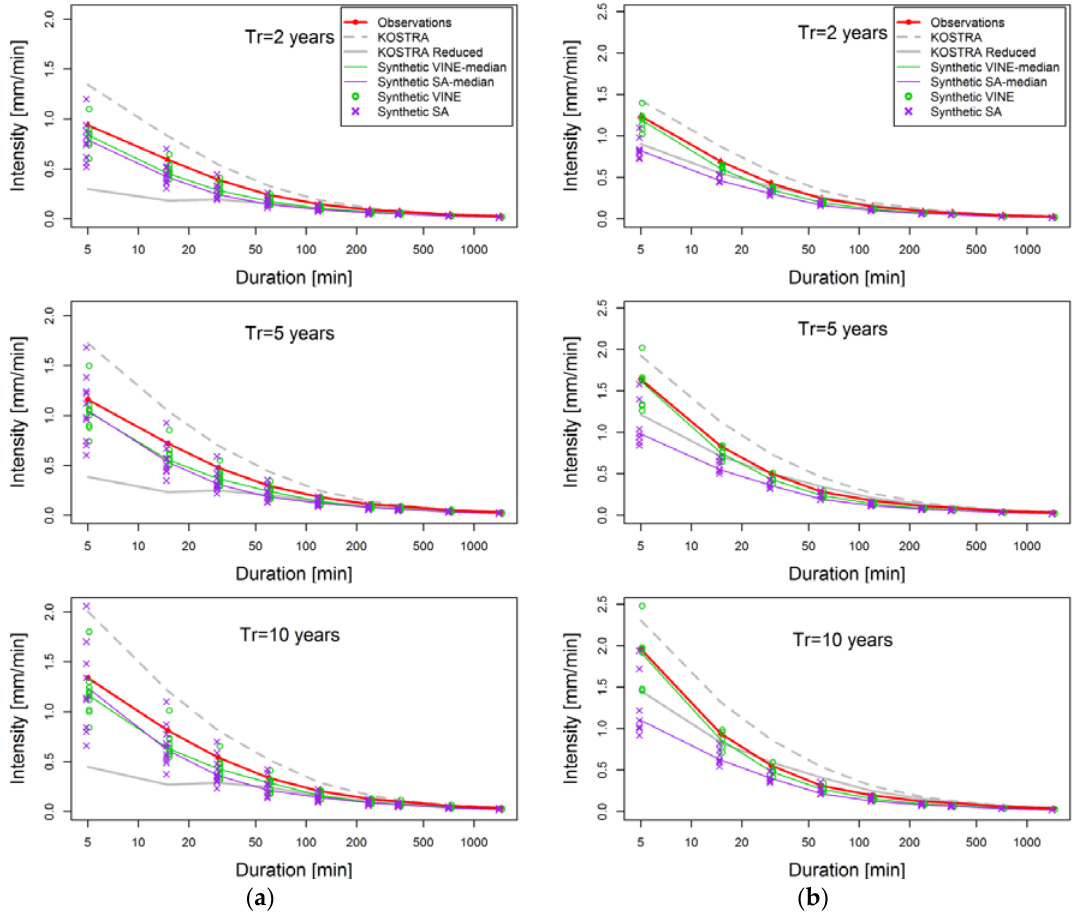
Figure 11. Comparison of IDF curves obtained from observed, KOSTRA, KOSTRA Reduced, and simulated time series (all realizations are shown as symbols: circles for Vine and crosses for SA) for the cases: ( a ) NS_B corresponding to the biggest area; ( b ) BAWU_D involving the smallest area.